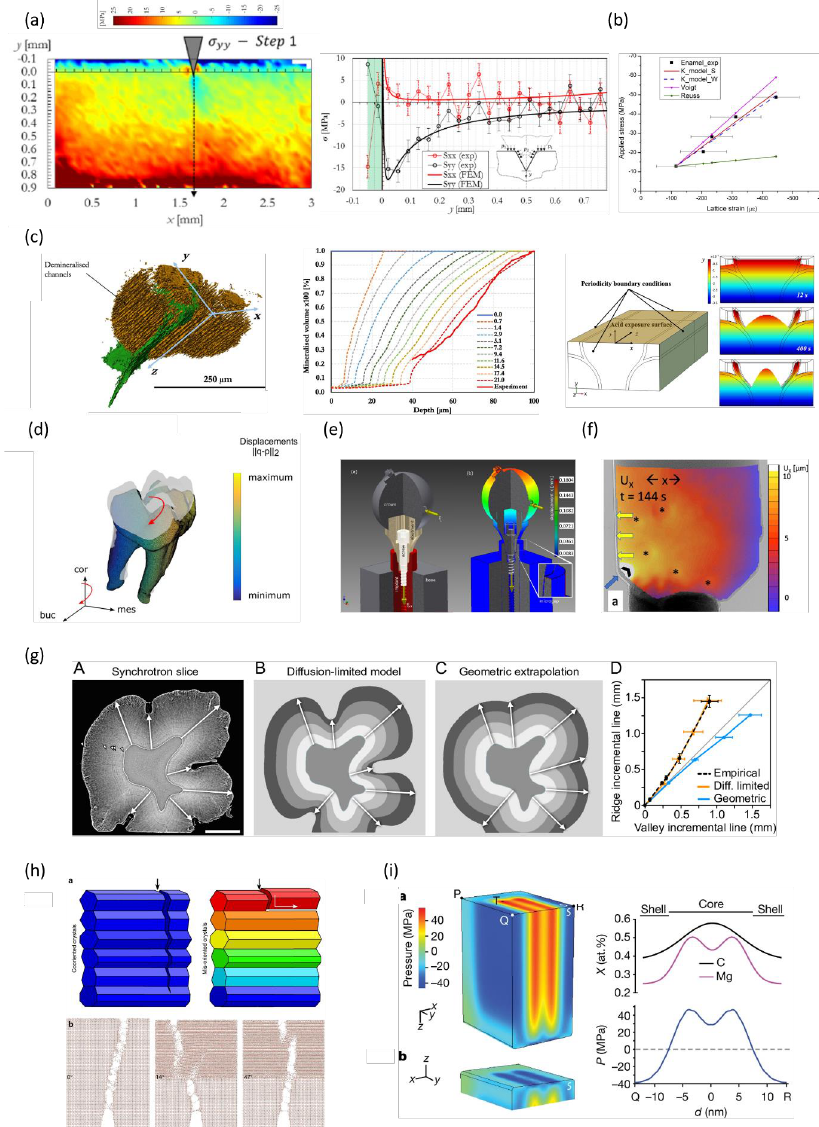
Figure 7. Application of modelling, simulation, finite element analysis, and molecular dynamics based on synchrotron experiments in dental research. ( a ) Analysis of the crack tip stress field in human enamel from WAXS data and the plot of the stress as a function of position (adapted from [349] with permission, Trans Tech Publications; Trans Tech Publications Ltd.). ( b ) Modelling results showing applied stress as a function of lattice strain in enamel, and in comparison to WAXS and